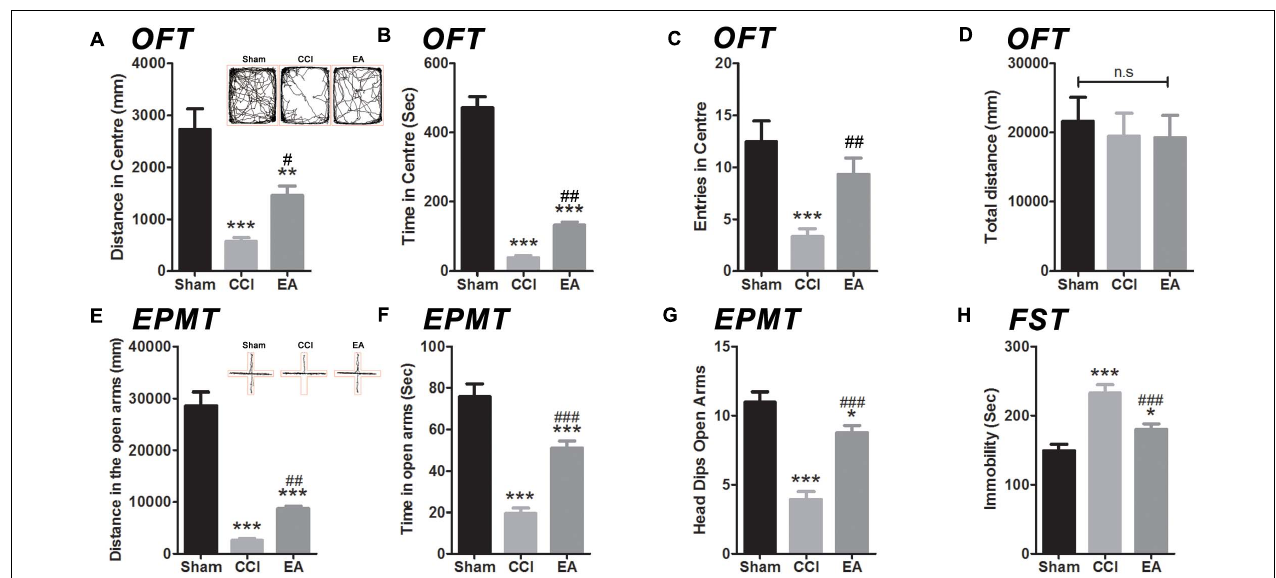
FIGURE 2 | The effects of EA on depressive and anxiety-like behaviors induced by CCI rats. The anxiety-like behavior was accessed by both in the open field test (OFT) (A–D) and elevated plus maze test (EPMT) (E,F) . (A) Distance in center of the OFT; (B) time spent in center of the OFT; (C) entries in center of the OFT; (D) total distance in the OFT; (E) distance in the open arms of the EPMT; (F) time spent in the open arms of the EPMT; (G) the frequency number of head dips (EPMT). The depressive-like behavior was in the forced swimming test (FST) (H) . All data are expressed as the mean ± SEM ( n = 13 per group). * p < 0.05, ** p < 0.01, *** p < 0.001 vs. the sham group; # p < 0.05, ## p < 0.01, ### p < 0.001 vs. the CCI group. The “n.s” means no statistical differences were observed among three